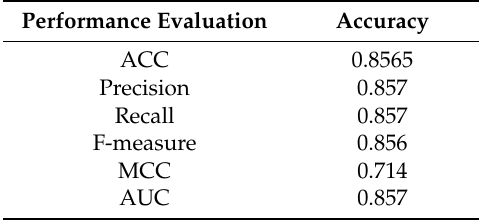
Table 1. The performance of our proposed